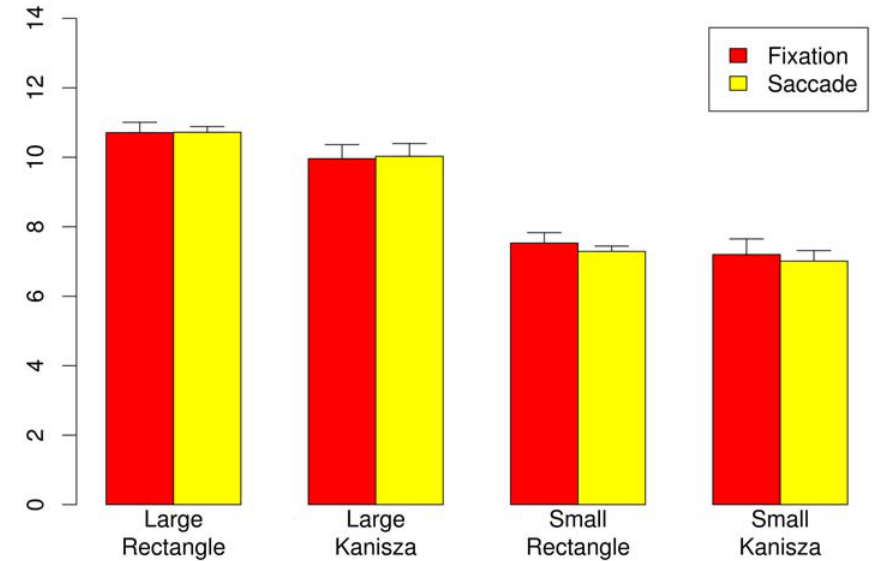
Figure 9. Experiment 2: Perceived height (50% PSE thresholds) for the fixation and saccade conditions. Vertical bars indicate 95% within subject confidence intervals [17]. figure is perceived as horizontally compressed and that the magnitude of such saccadic compression is dependent upon the distance between individual elements of the figure. However, our results extend the previous findings in several important ways. Most importantly, we show for the first time that compression of the Kanizsa figure is larger in the horizontal than in the vertical dimension. Sogo and Osaka examined only perceived compression in the horizontal dimension, and thus, their results are consistent with the possibility that Kanizsa figures are compressed in both horizontal and vertical dimensions and do not exclude the possibility that vertical compression is larger. The results of our experiments are unequivocal: horizontal compression is larger than vertical compression.